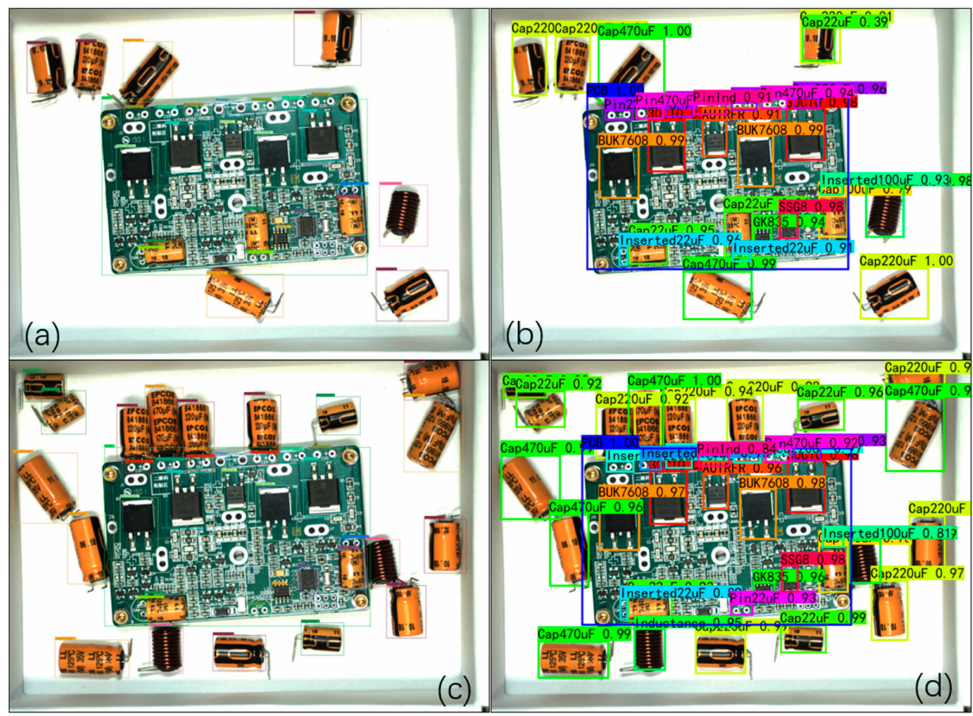
Figure 14. Object detection result during PCB assembly based on Balanced-YOLOv3 ( a ) Ground truth of original image1 during assembly ( b ) Object detection result of original image1 during assembly ( c ) Ground truth of original image2 during assembly ( d ) Object detection result of original image2 during assembly.